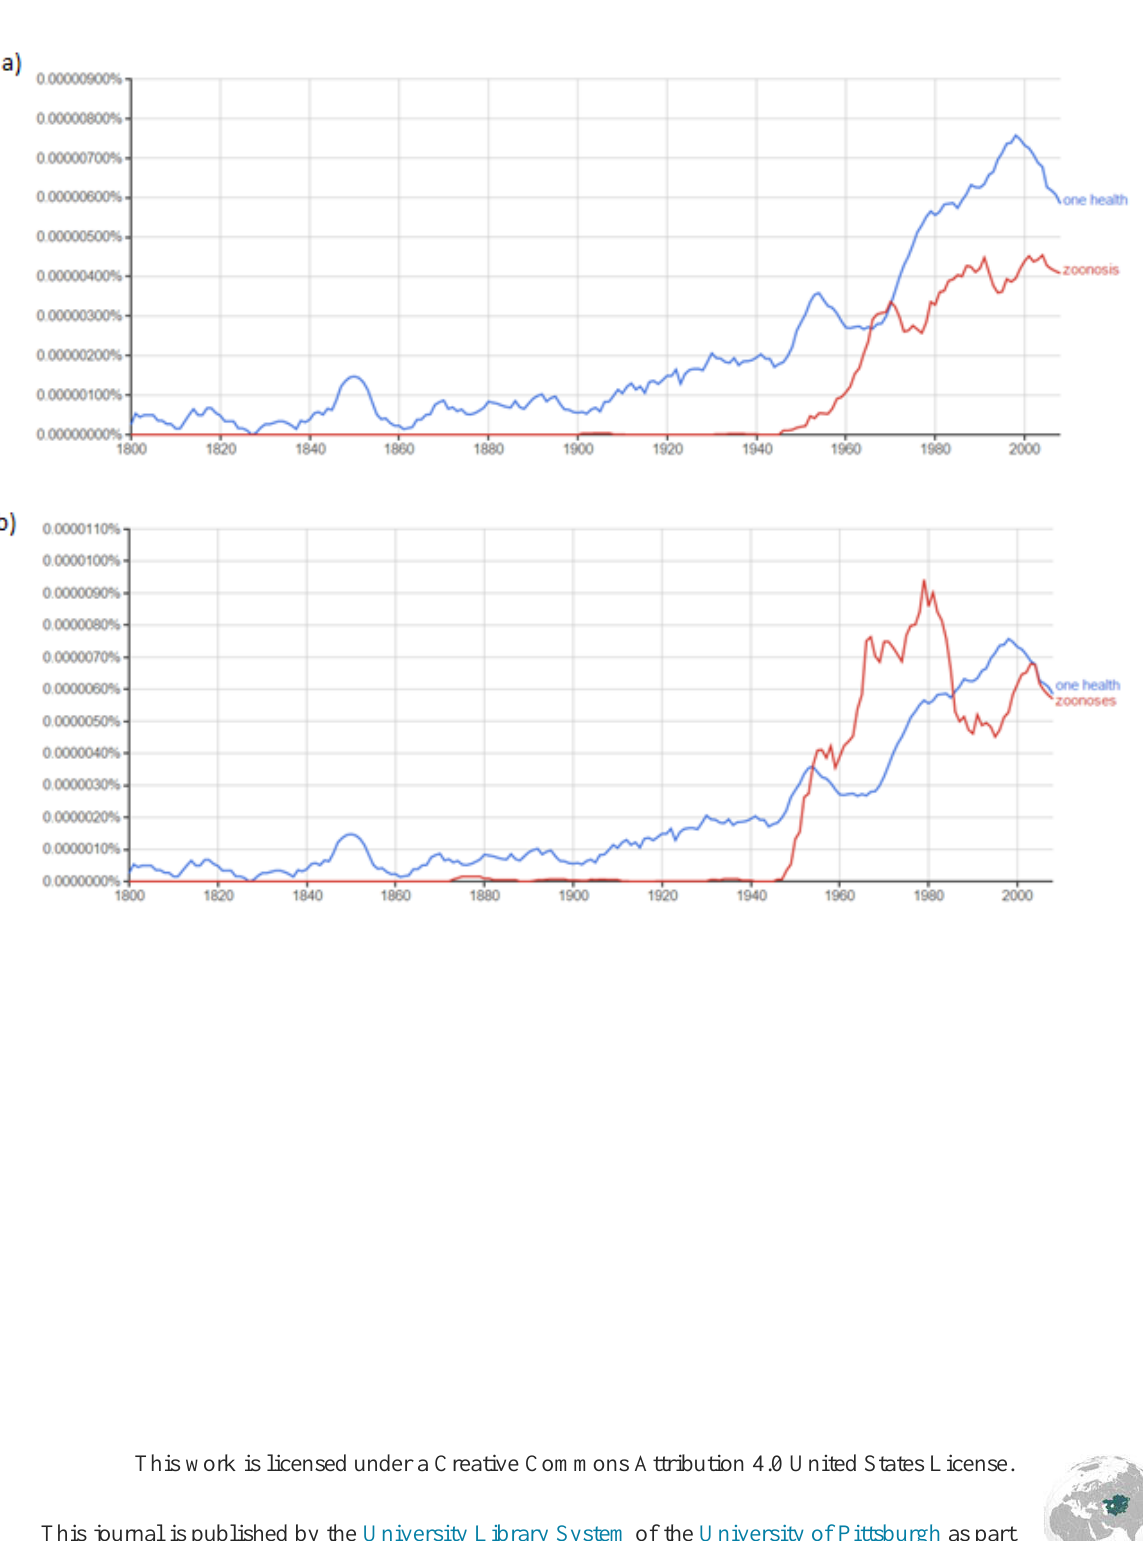
Figure 2: Ngram analysis of zoonosis/zoonoses and One Health